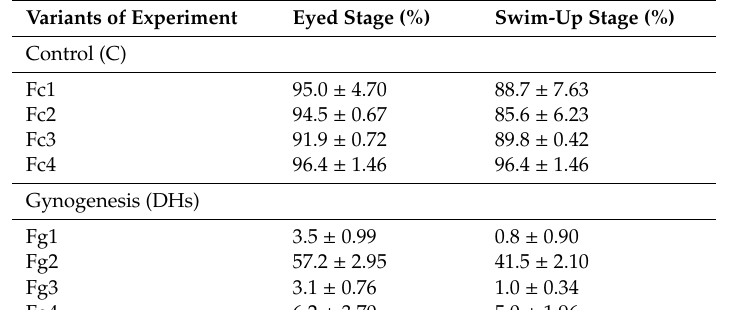
Table 1. Survival rates (averages ± standard deviations (SD)) of the rainbow trout from the control (C) and the diploid gynogenetic doubled haploid (DHs) groups.